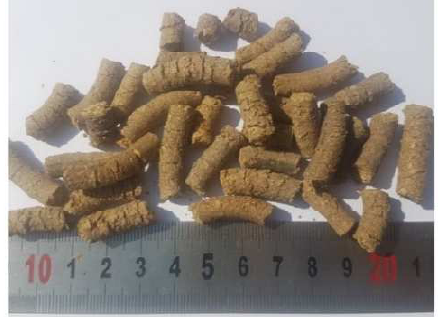
Figure 1. Sample pellets.